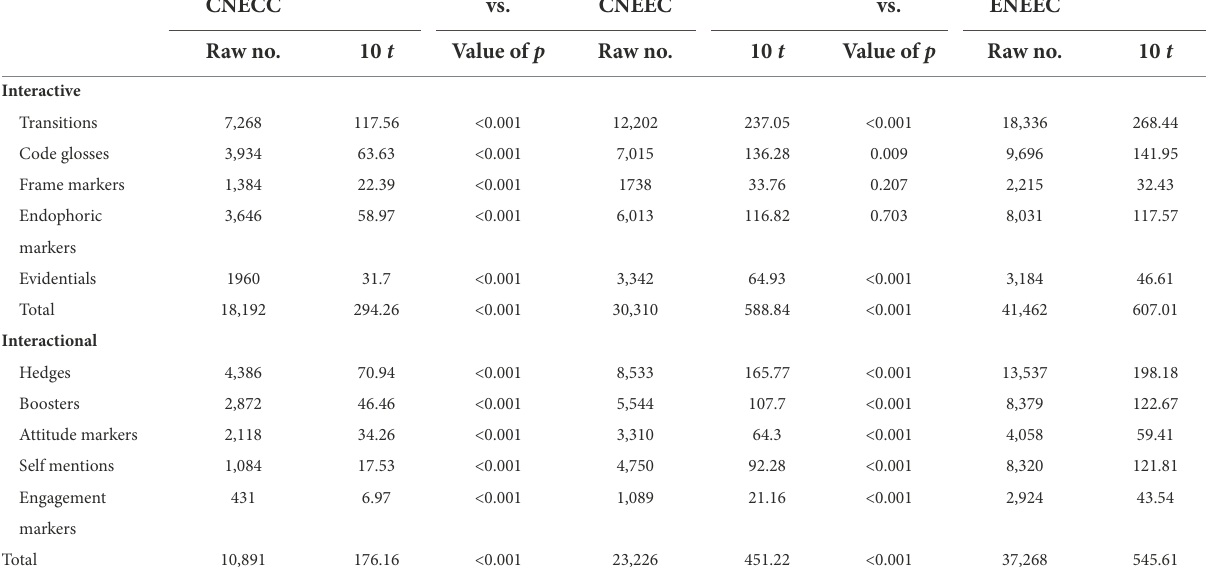
TABLE 3 Frequencies of metadiscourse in CNECC, CNEEC, and